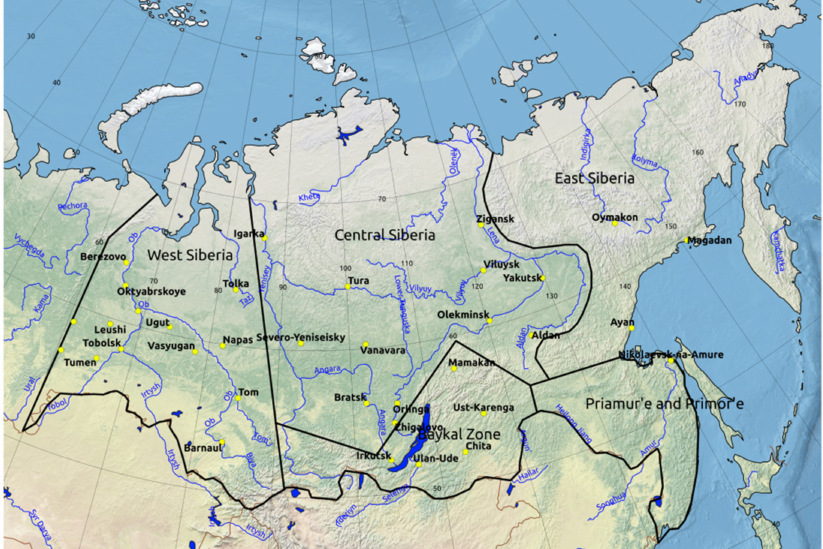
Figure 1. Map of Siberian territory. Yellow circles are meteorological stations. Black lines are boundaries of Siberian districts (approximately, according to